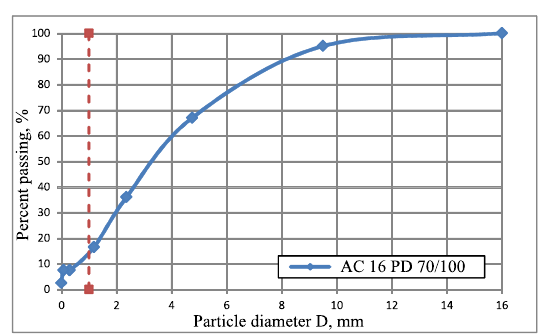
Fig. 7. A scheme of the Marshall test, where: 1 and 3 are metal plates and 2 – Marshall test specimen Fig. 8. Typical Marshall test graphic